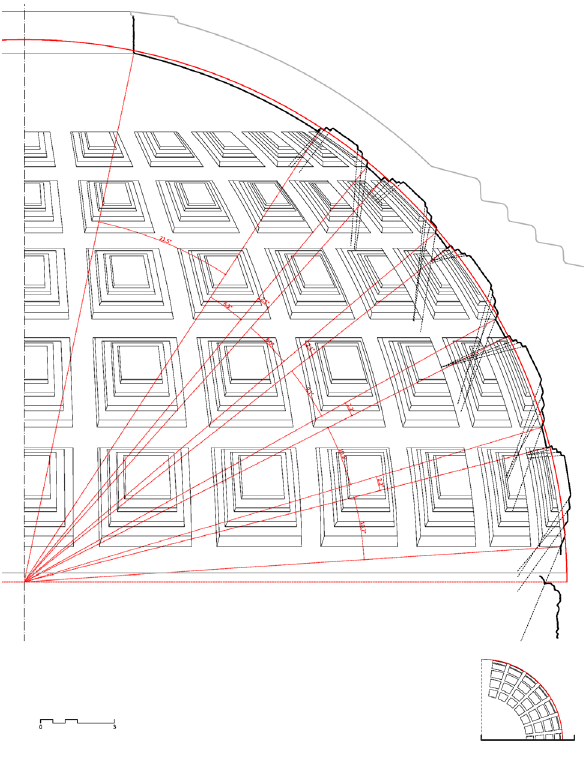
Figure 4. Study of a section of the Nord-East quadrant of the dome showing the offset between the cornice plan and the centre of the inscribed